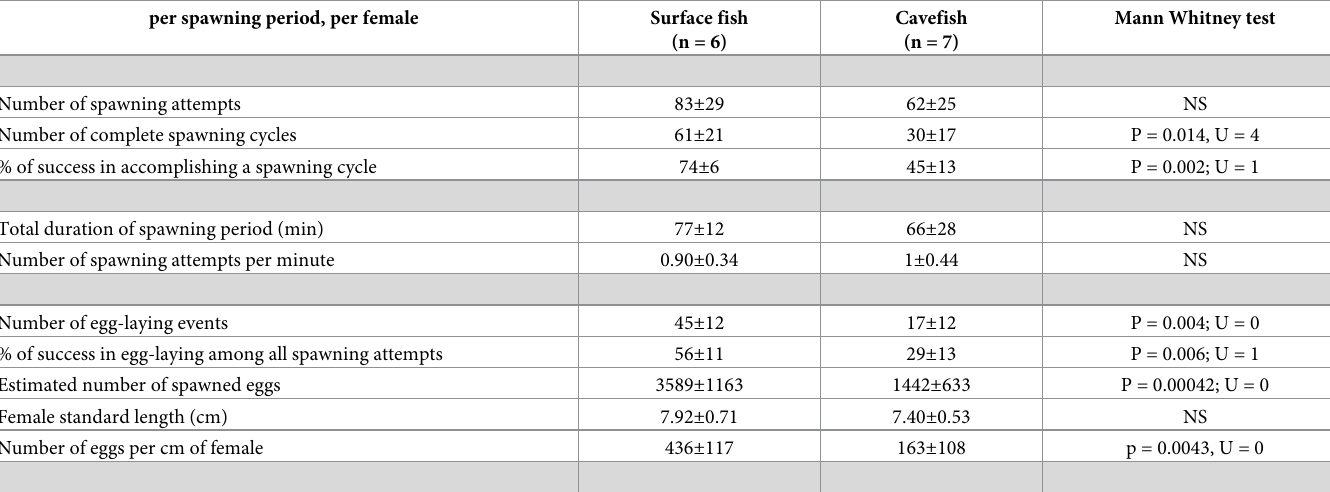
Values are given as mean ± SD. P and U values are indicated after Mann Whitney